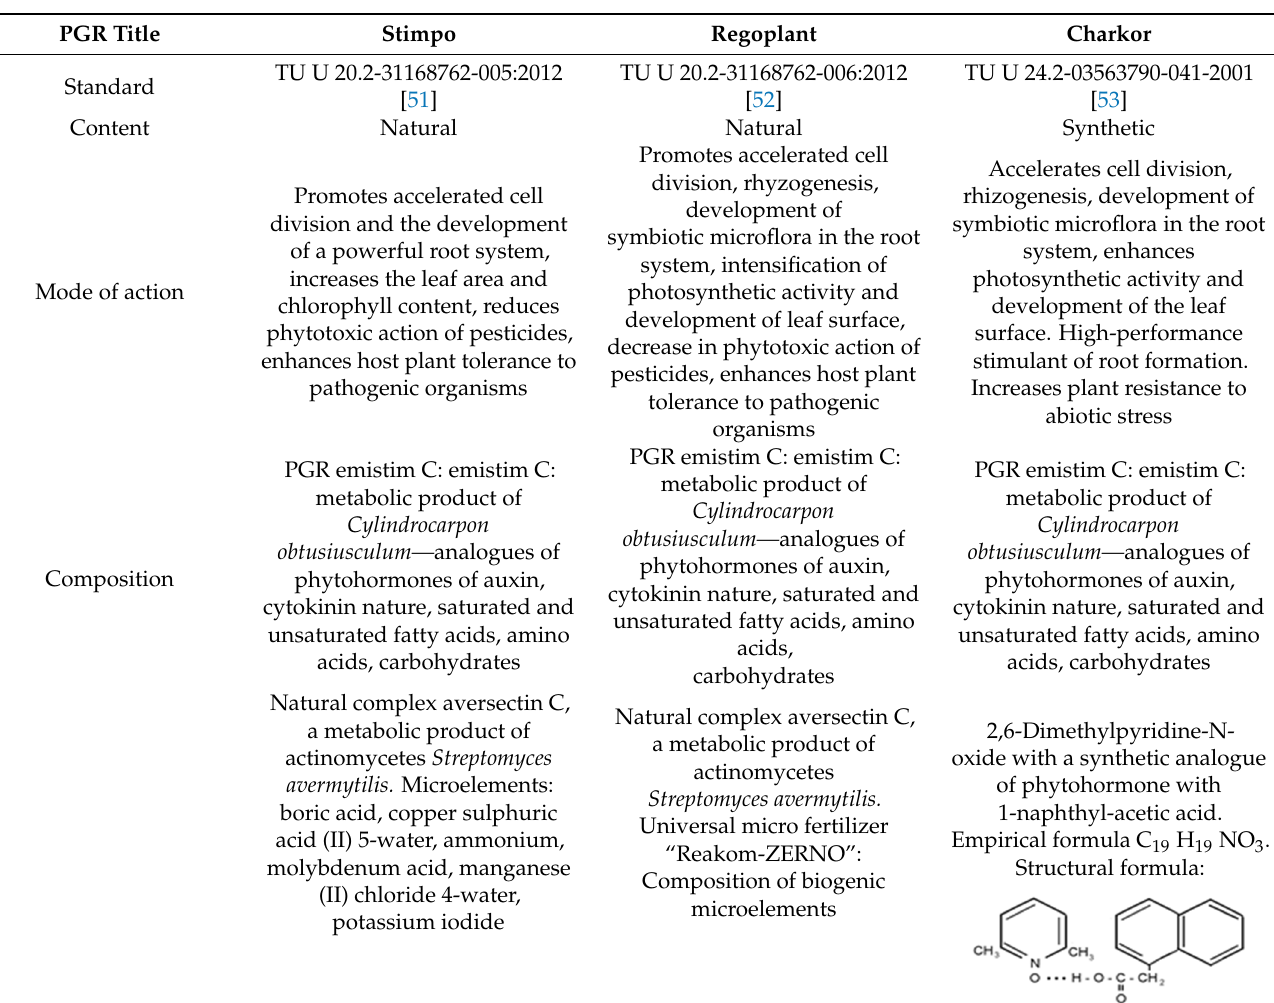
Table 3. Characteristics of PGRs used for the treatment of M. × giganteus (adapted from [16,36]